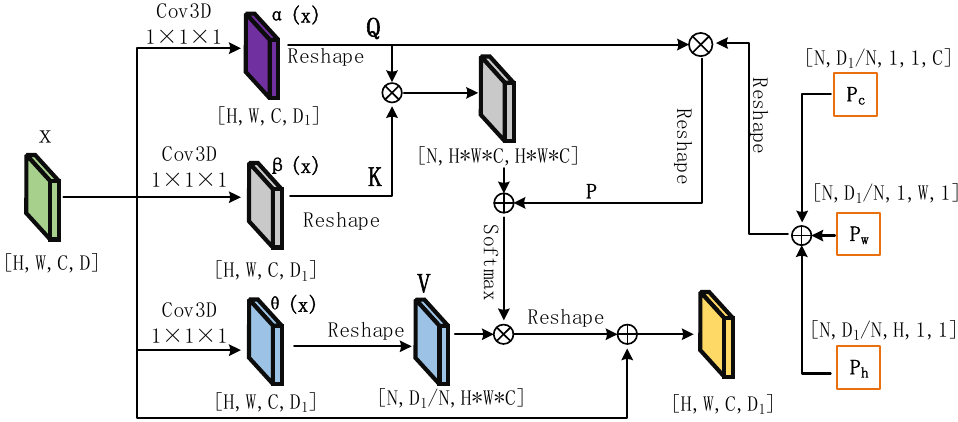
Figure 3. Improved 3D multi-head self-attention.